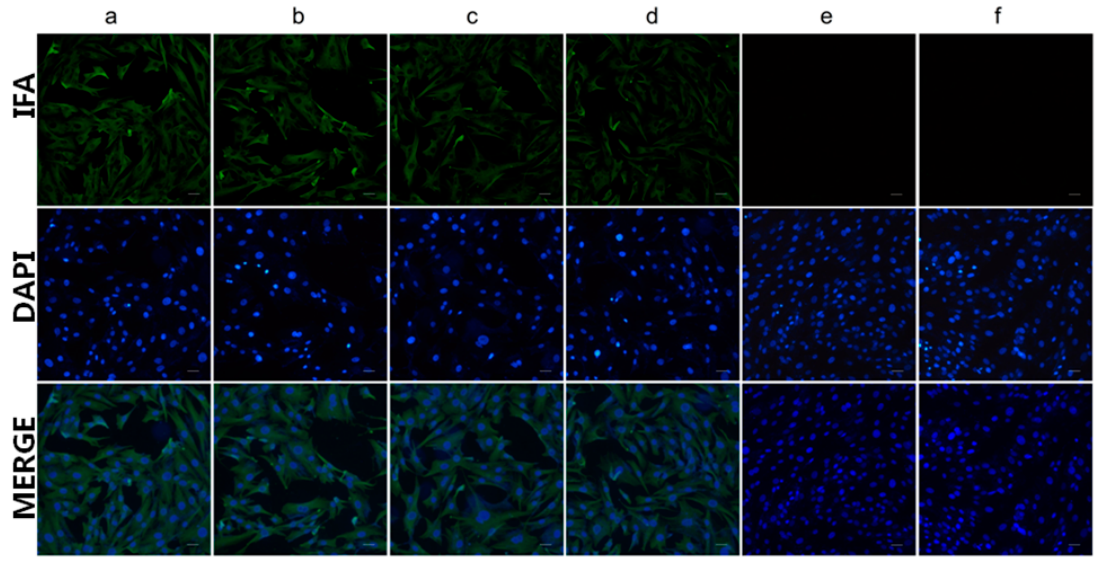
Figure 6. Detection of the DHAV infection in duck embryonic hepatocytes (DEH) cells by IFA: ( a ) the DEH cells infected by DHAV-1 were detected using mAb 4E6; ( b ) the DEH cells infected by DHAV-3 were detected using mAb 4E6; ( c ) the DEH cells infected by DHAV-1 were detected using rabbit anti-Pep1 serum; ( d ) the DEH cells infected by DHAV-3 were detected using rabbit anti-Pep1 serum; ( e ) the DEH cells un-infected were detected using mAb 4E6; ( f ) the DEH cells un-infected were detected using rabbit anti-Pep1 serum. Bars, 50µm.